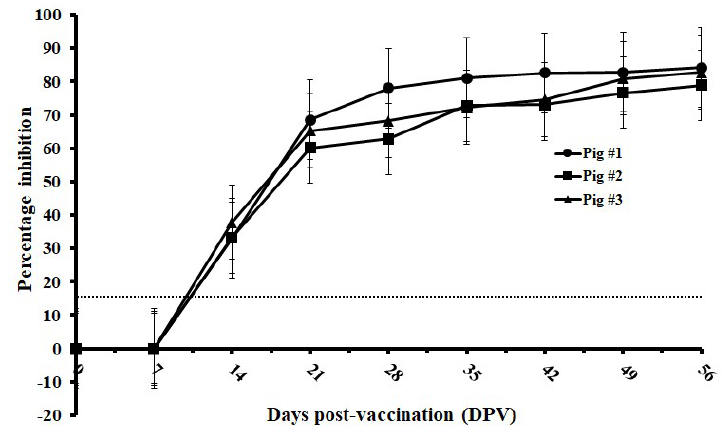
Figure 5. Kinetics of E rns antibody response of C-strain-vaccinated pigs tested by mAb1504-based cELISA. Serum samples were derived from C-strain-vaccinated pigs ( n = 3) at every 7 days. The dotted line represents cut-off value: 16%.